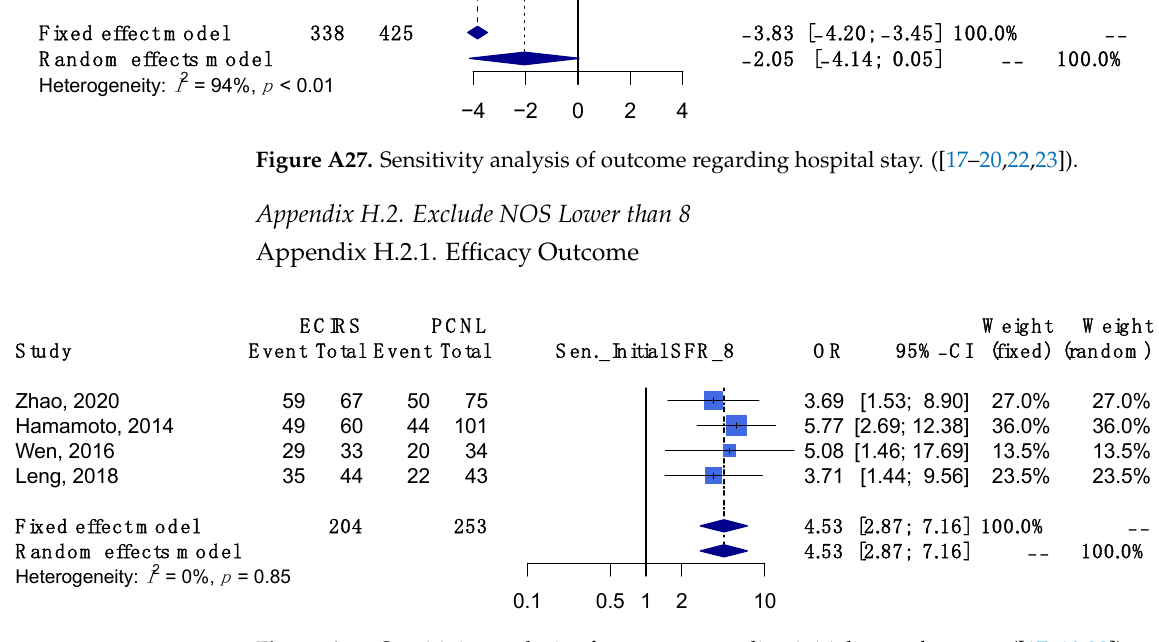
Figure A27. Sensitivity analysis of outcome regarding hospital stay. ([17–20,22,23])